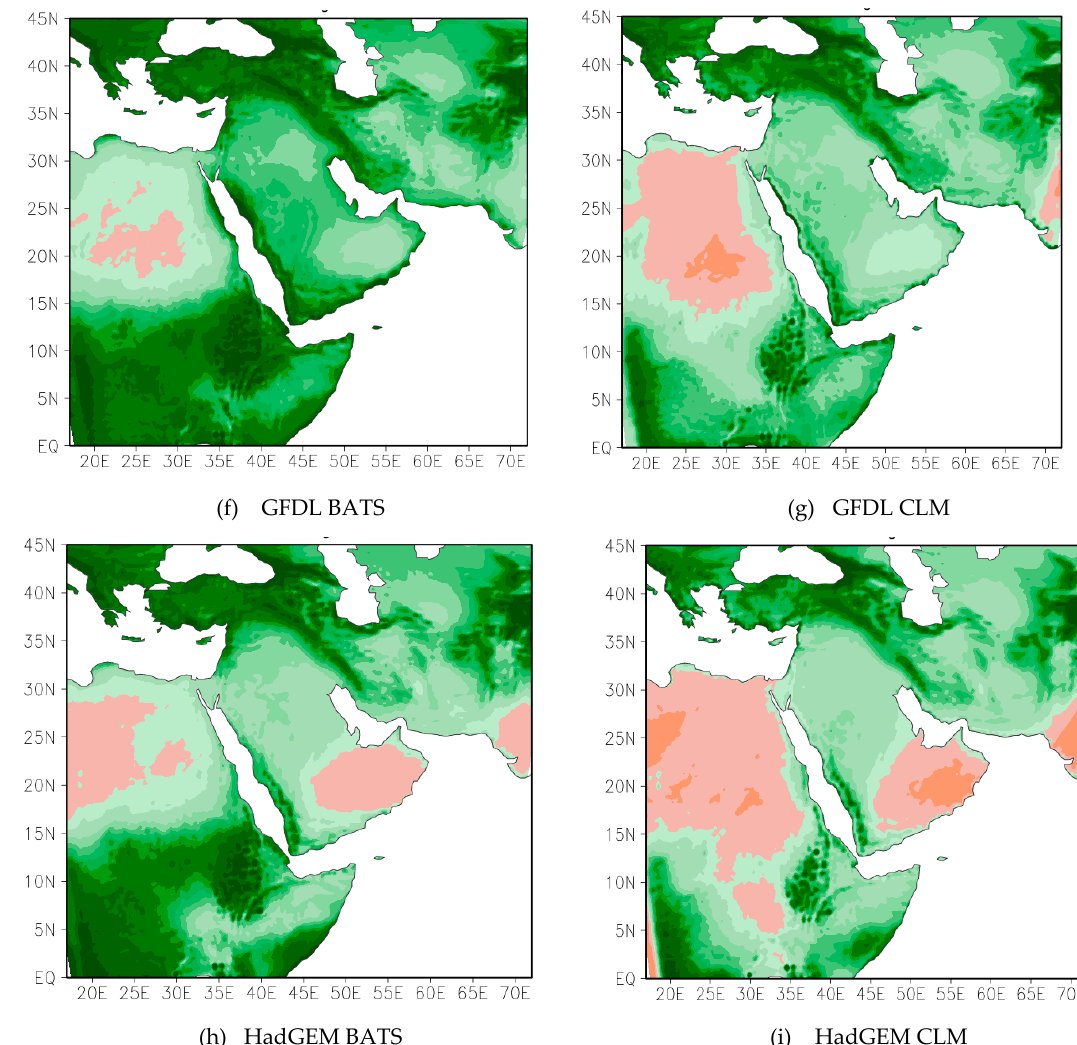
Figure 3. Spatial distribution of annual precipitation (mm) for ( a ) CRU, ( b ) ERA – Int BATS, ( c ) ERA – Int CLM, ( d ) ECHAM6 BATS, ( e ) ECHAM6 CLM, ( f ) GFDL BATS, ( g ) GFDL CLM, ( h ) HadGEM BATS, and ( i ) HadGEM CLM averaged over the period 1980 – 2005.